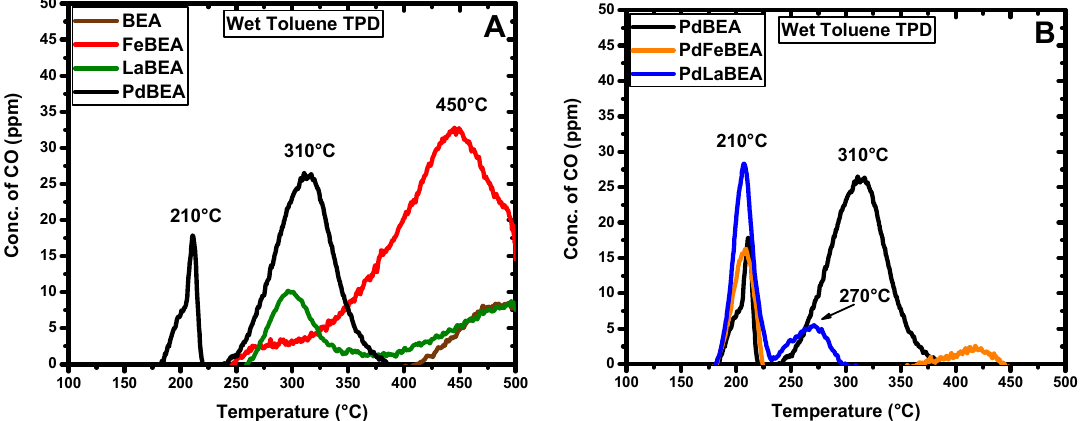
Figure 10. Temperature-programmed desorption of toluene at wet conditions where the concentration of formed CO is plotted against the corresponding temperature for ( A ) BEA, Fe / BEA, La / BEA, and Pd / BEA; and ( B ) Pd / BEA, Pd / Fe / BEA, and Pd / La /